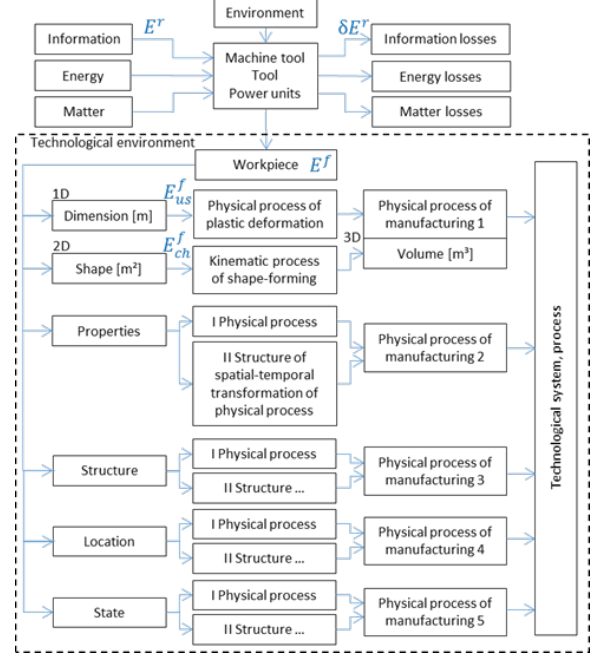
Fig. 2. Energy-informational model